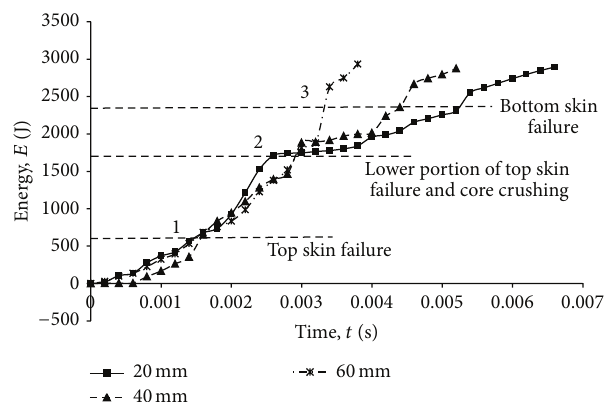
Figure 8: Energy profile diagram for the sandwich composite subjected to 30 J of impact energy.